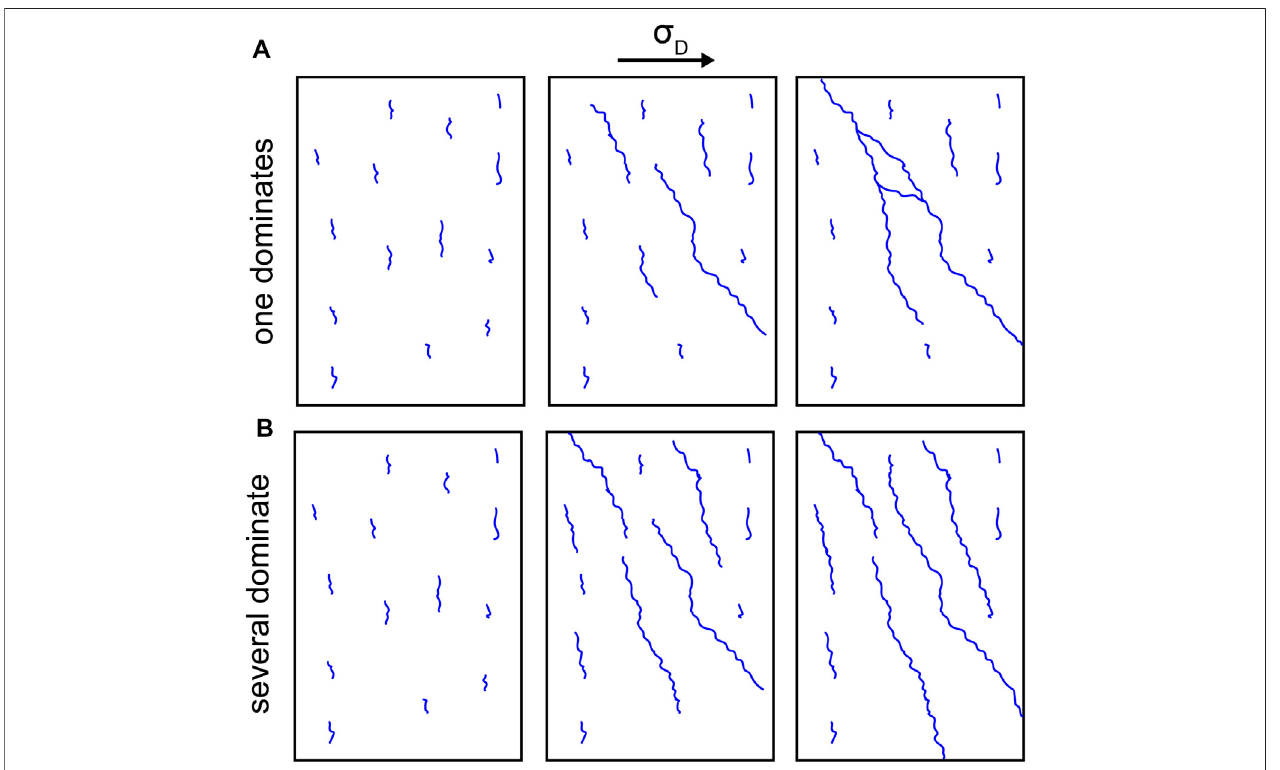
FIGURE 12 | Fracture network development in a rock in which the one largest fracture dominates development (A) and in which several of the largest fractures dominate (B) . The localization observed in experiments monzonite #3 and granite #4 most closely match (A) , while the other experiments most closely match (B)